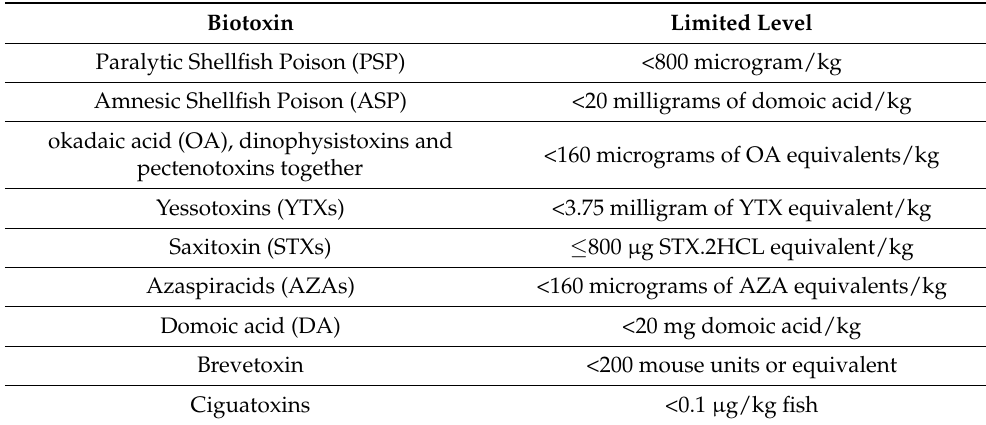
Table 1. Maximum permitted level of marine biotoxins in total quantities. “Total quantity means measured in the whole bivalve molluscs body or each edible parts separately”